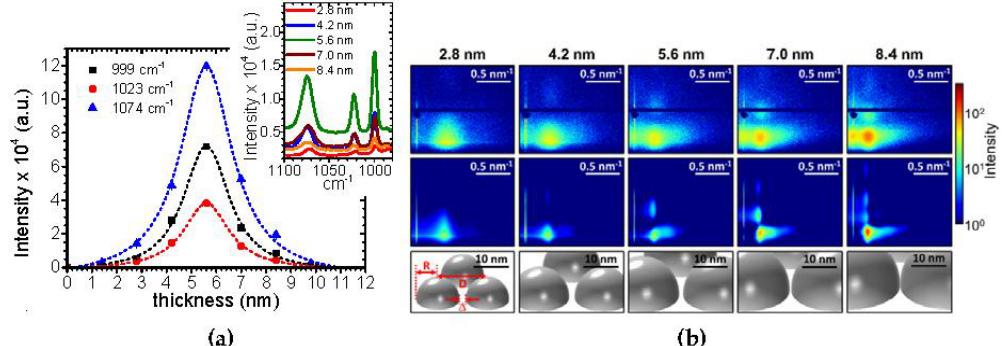
Figure 6. Sputter deposition of Ag on amorphous silicon oxide. ( a ) Surface enhanced Raman scattering (SERS) signals from 10 −7 mM thiophenol at different deposited silver thicknesses, having different sputter deposited Ag nanostructures on amorphous silicon oxide. The inset shows SERS signal as a function of wavelength for different Ag layer thicknesses. ( b ) Upper row: GISAXS data (upper row) at the different Ag thicknesses indicated above each pattern. Middle row: Model-based simulations (middle row) of the expected GISAXS pattern of the corresponding real-space model (bottom row). The maximum SERS signal corresponds to an effective Ag thickness of δ Ag = 5.6 nm. D denotes the center-to-center distance, R the cluster radius and ∆ the void size. Reproduced with permission from [169]. Copyright AIP Publishing, 2014.